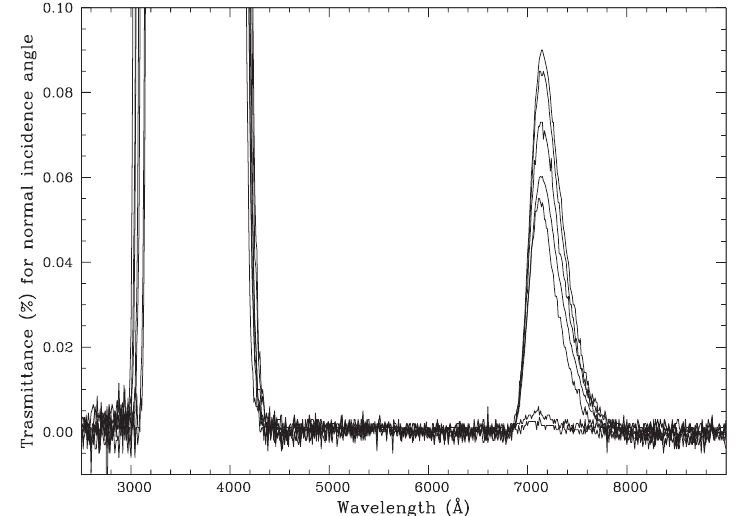
Fig. 10. Transmittance of some U filters from the classical sandwiches of colored glasses variety replotted from Figure 1 at a much streched ordinate scale. Note the varying effectivness of Schott UG 2 glass in suppressing the red leak longward of 685